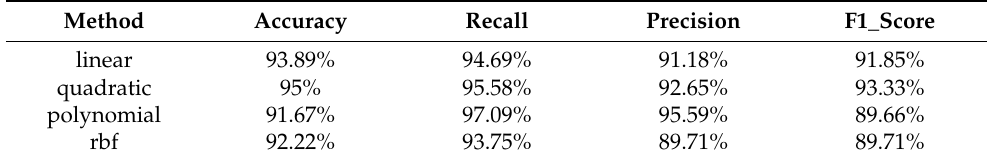
Table 6. Testing results using ACO as a feature selection